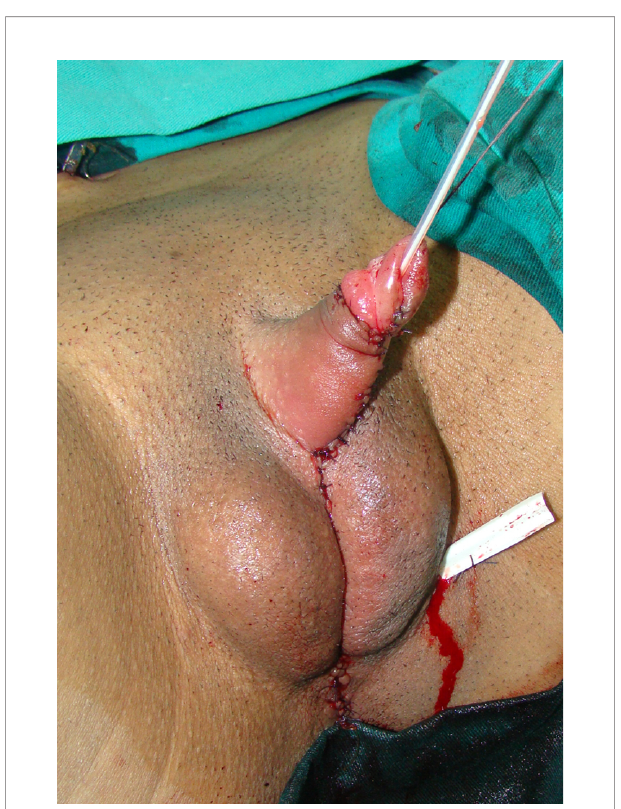
FIGURE 8 | Appearance at the end of surgery. Good size of the neophallus is achieved. Scrotums are created from labia majora and testicular prostheses are